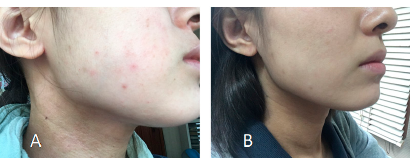
Figure 12. Facial photo before ( A ) and two weeks after application ( B ) of SE Moisture Creamy Gel (taken on 17 April 2018) (unpublished (taken on 17 April 17 2018) (unpublished data).